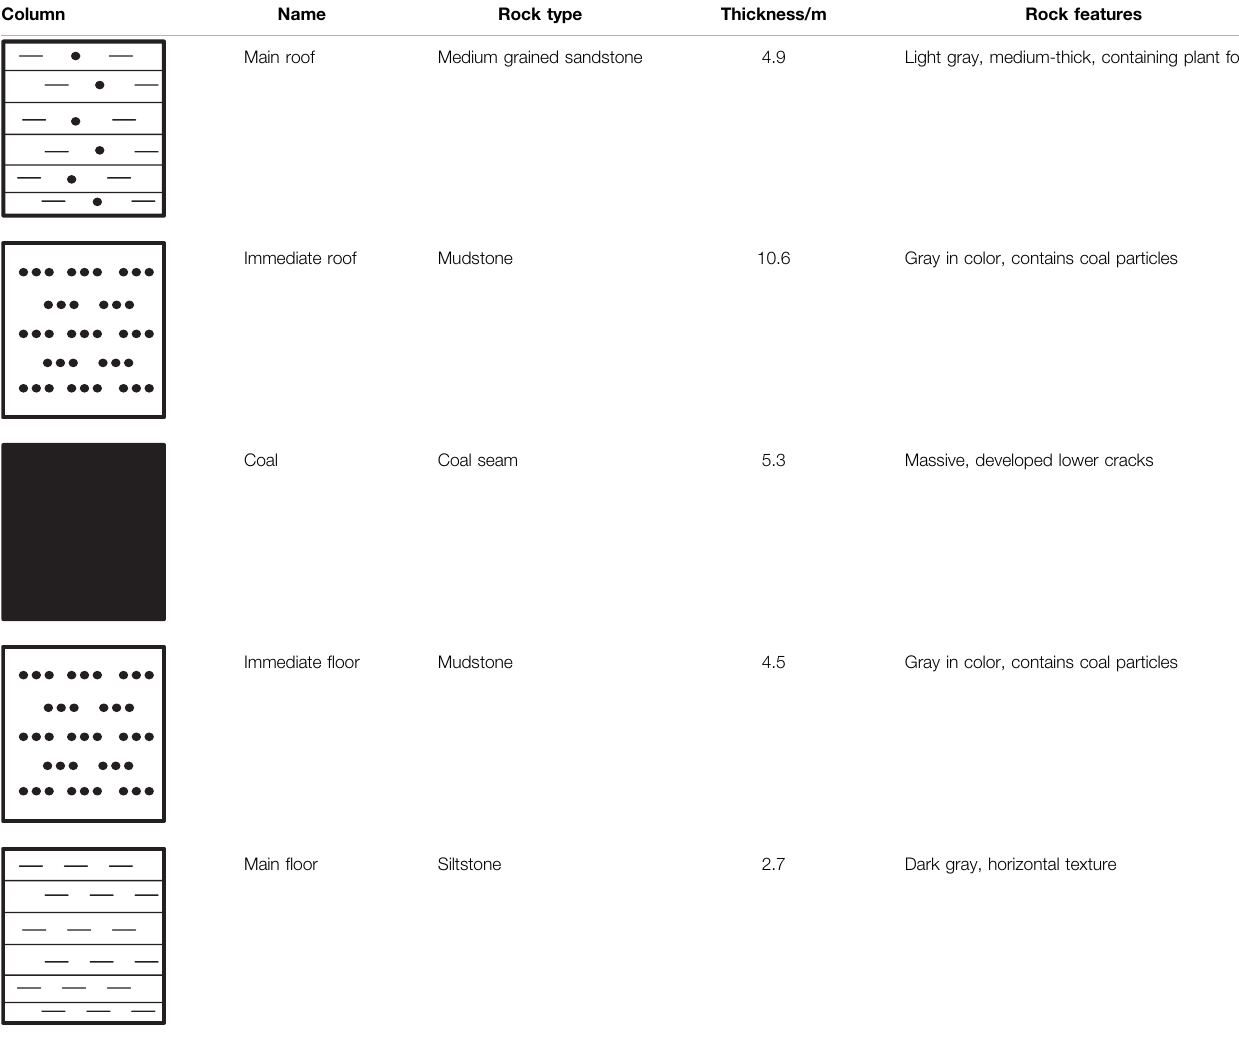
TABLE 1 | Condition of coal seam roof and fl oor.